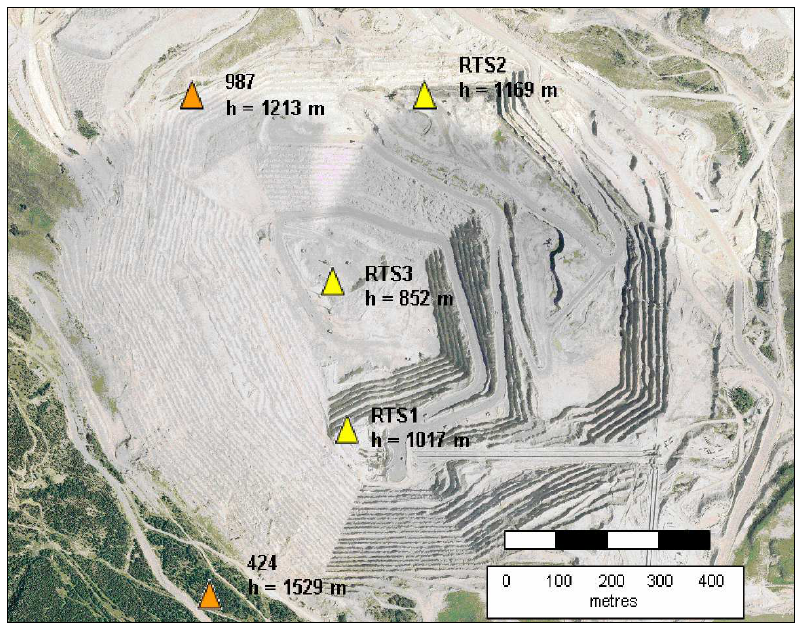
Figure 1. Large Open Pit Mine Test (with station heights